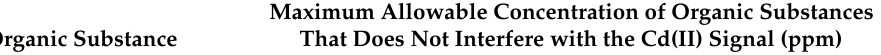
Figure 6. Influence of CTAB ( a,f ), HA ( b,d ), and FA ( c,e ) on the cadmium peak intensity using the procedure without ( a – c ) and with ( d – f ) preliminary mixing with Amberlite XAD-7 resin. Concen- tration of Cd(II) 5 × 10 − 8 M, accumulation potential − 0.7 V, and accumulation time 60 s. Table 2. Influence of CTAB, HA, and FA on the Cd(II) voltammetric signal using the procedure with and without preliminary mixing with Amberlite XAD-7 resin. Concentration of Cd(II) was 5 × 10 − 8 M.